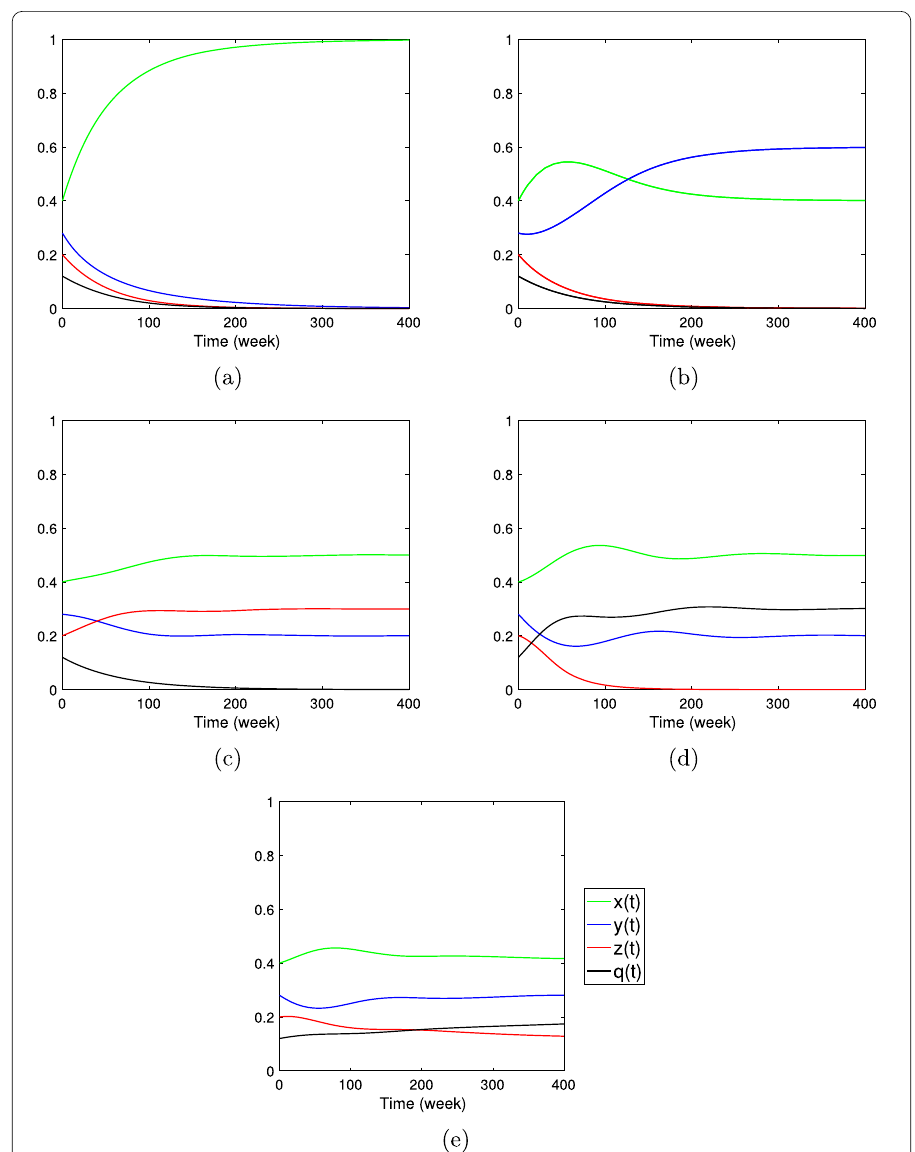
Figure 2 The dynamical behavior of system (2) with different sets of parameters. ( a ) Free equilibrium E 1,0 , ( b ) Overweight equilibrium E 1,1 , ( c ) Free quitter equilibrium E 1,2 , ( d ) Free obese equilibrium E 1,3 , ( e ) Positive equilibrium E